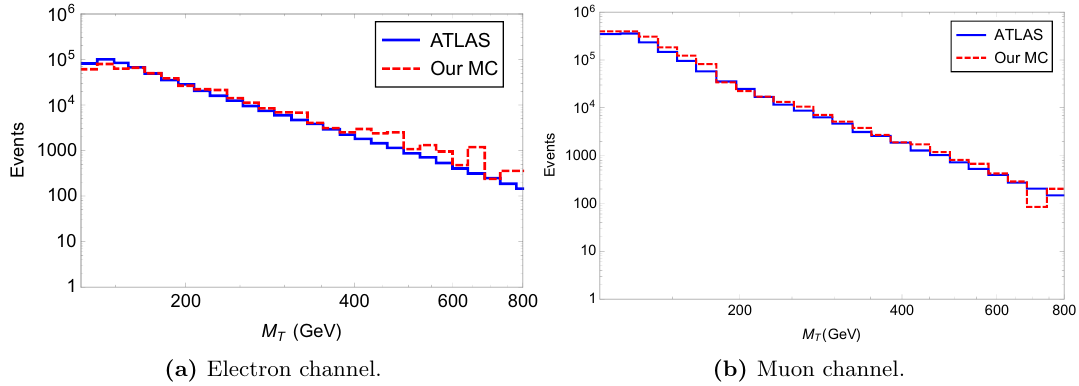
Figure 6. The comparison between the ATLAS and our background simulation for the monolepton analysis ( W ‘(cid:23) ). !